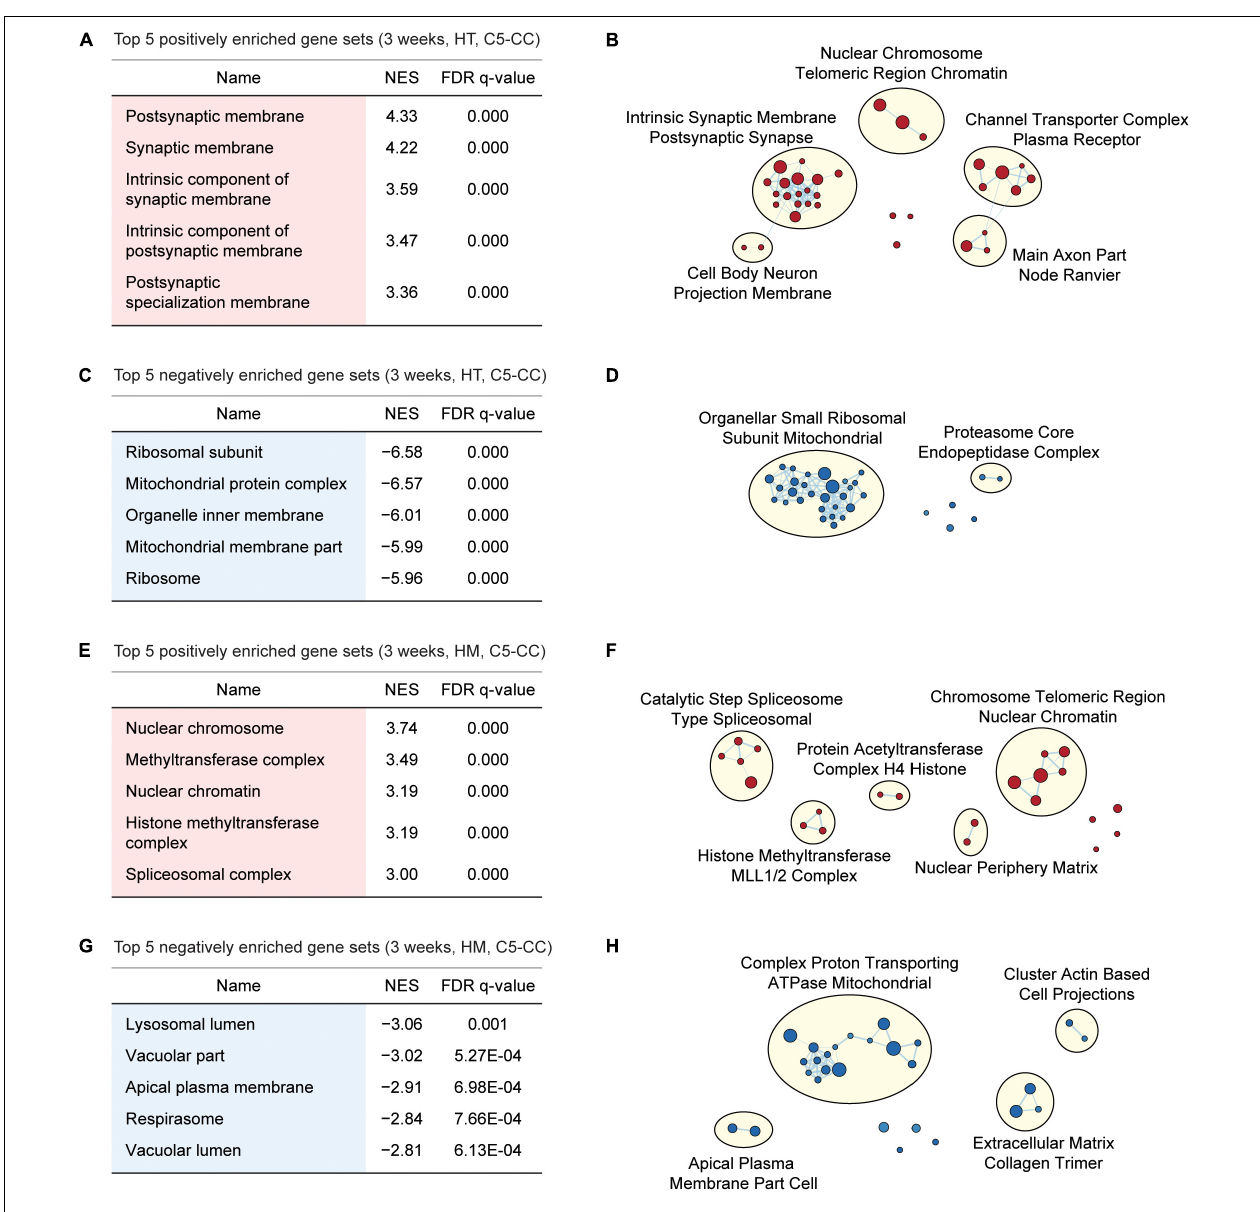
FIGURE 3 | GSEA of transcriptomes from W3-HT and W3-HM Shank2 -mutant mice for biological functions. (A–D) GSEA results for W3-HT transcripts showing the list of top five positively (red) and negatively (blue) enriched gene sets (A,C) and their integrated visualization generated using EnrichmentMap Cytoscape App (B,D) . Only the results for C5-CC (cellular component) are shown here, and those for C5-BP (biological process) and C5-MF (molecular function) are shown in Supplementary Figures 2 , 3 . Note that, although the top five gene sets are shown in the main figure tables for simplicity (see the full lists in Supplementary Tables 4–7 ), EnrichmentMap visualization utilized all of the GSEA results ( n = 5 mice for WT, HT, and HM, FDR < 0.05). (E–H) GSEA results for W3-HM transcripts (E,G) and their integrated visualization generated using EnrichmentMap (F,H) ( n = 5 mice for WT, HT, and HM, FDR < 0.05). See Supplementary Figures 4 , 5 for GSEA results for C5-BP and C5-MF.